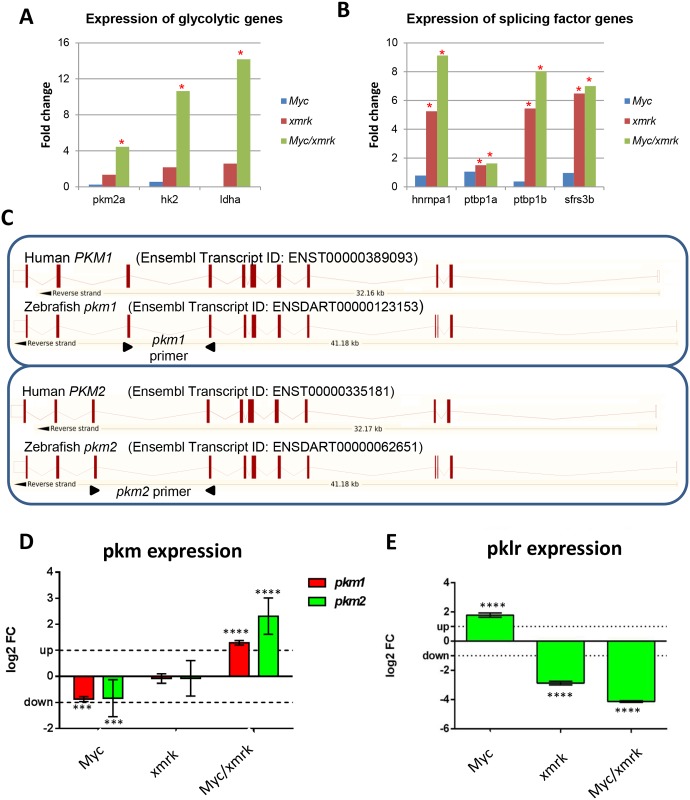
Expression of Warburg effect genes.(A) Expression of glycolytic genes in Myc, xmrk and Myc/xmrk tumors. (B) Expression of glycolytic genes splicing factors in Myc, xmrk and Myc/xmrk tumors. Asterisks indicate significantly changed genes (fold change>1.5, P<0.05). (C) Schematic comparison of genomic structure of human and zebrafish PKM1/pkm1and PKM2/pkm2 isoforms. The primers used for RT-qPCR are indicated by arrowheads. (D) RT-qPCR quantification of zebrafish pkm1 and pkm2expression in three tumor samples as compared with non-tumor controls. ***P<0.001; ****P<0.0001. (E) RT-qPCR quantification of pklr expression in three tumor samples as compared with non-tumor controls. ****P<0.0001.